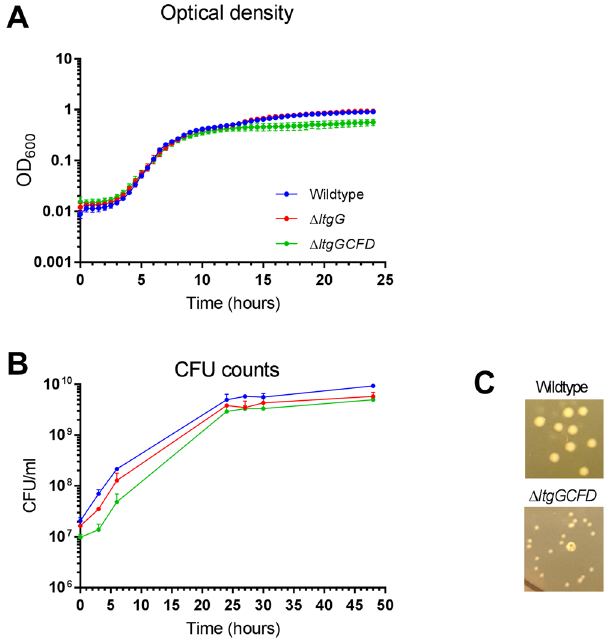
Figure 2. Multiple ltg deletion impacts on growth of B . pseudomallei . Growth of B . pseudomallei strains in LB was assessed by measuring optical density at 600 nm ( A ) or by CFU counting ( B ). ( C ) B . pseudomallei were grown on LA plates for 36 h. Data are represented as mean ± STDV (n = 7 for A, n = 2 for B). Analysis of growth parameters is presented in Supplementary Table